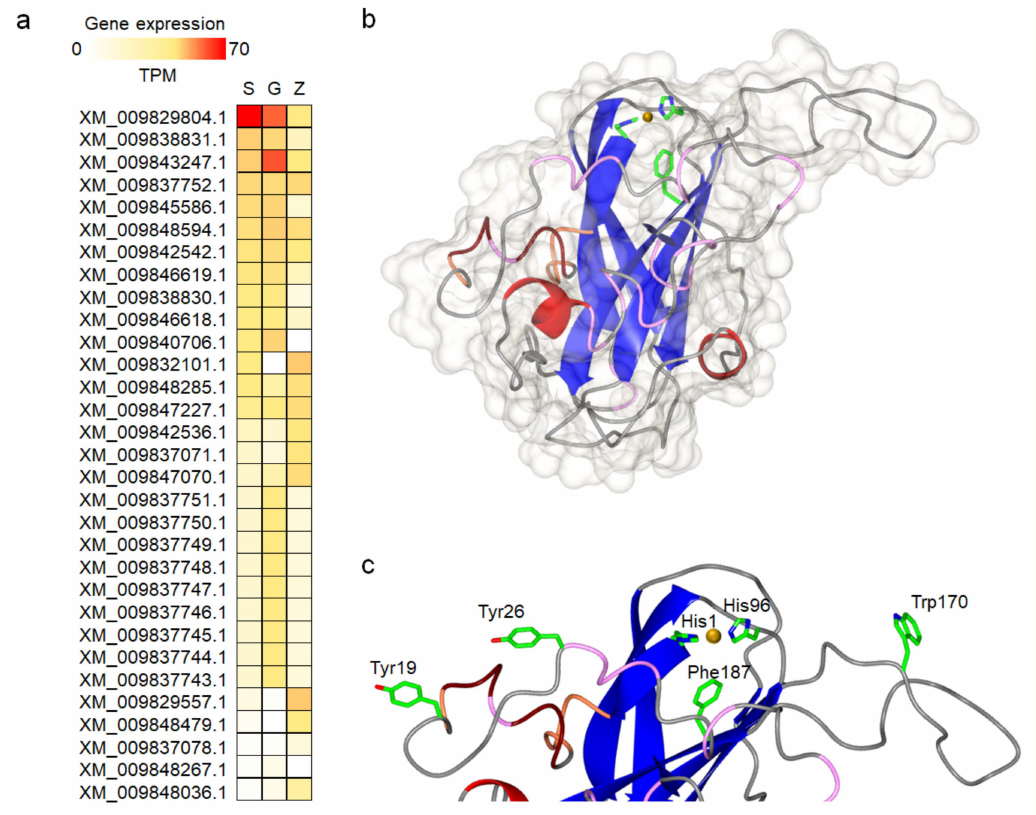
Figure 4. Gene expression of AA15 coding genes in A. astaci and structural homology modelling of Aa AA15A. ( a ) Relative gene expression levels for all AA15 genes across life stages were calculated using Salmon [25]. The highest expression level is observed for gene XM_009829804.1 ( Aa AA15A). TPM: transcripts per kilobase million. S: sporulating mycelia. G: growing mycelia. Z: zoospores. Raw data were obtained from accessions SRX236908, SRX236909 and SRX236910. ( b ) Homology model of Aa AA15A generated with Swiss-Model using the crystal structure of Td AA15A (PDB code: 5MSZ) as template. The model is shown as a cartoon colored by secondary structure with its surrounding surface shown in grey. ( c ) Close up view of the copper-coordinating “histidine brace” and aromatic residues at the substrate-binding